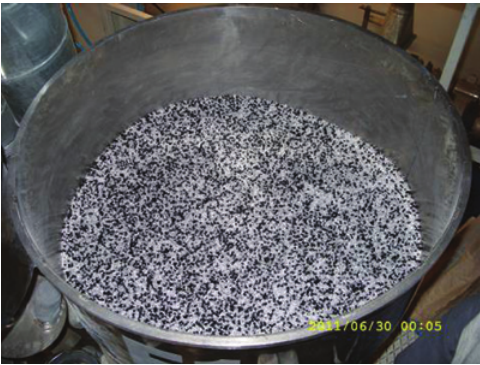
Table 4 Technical properties of injection molding